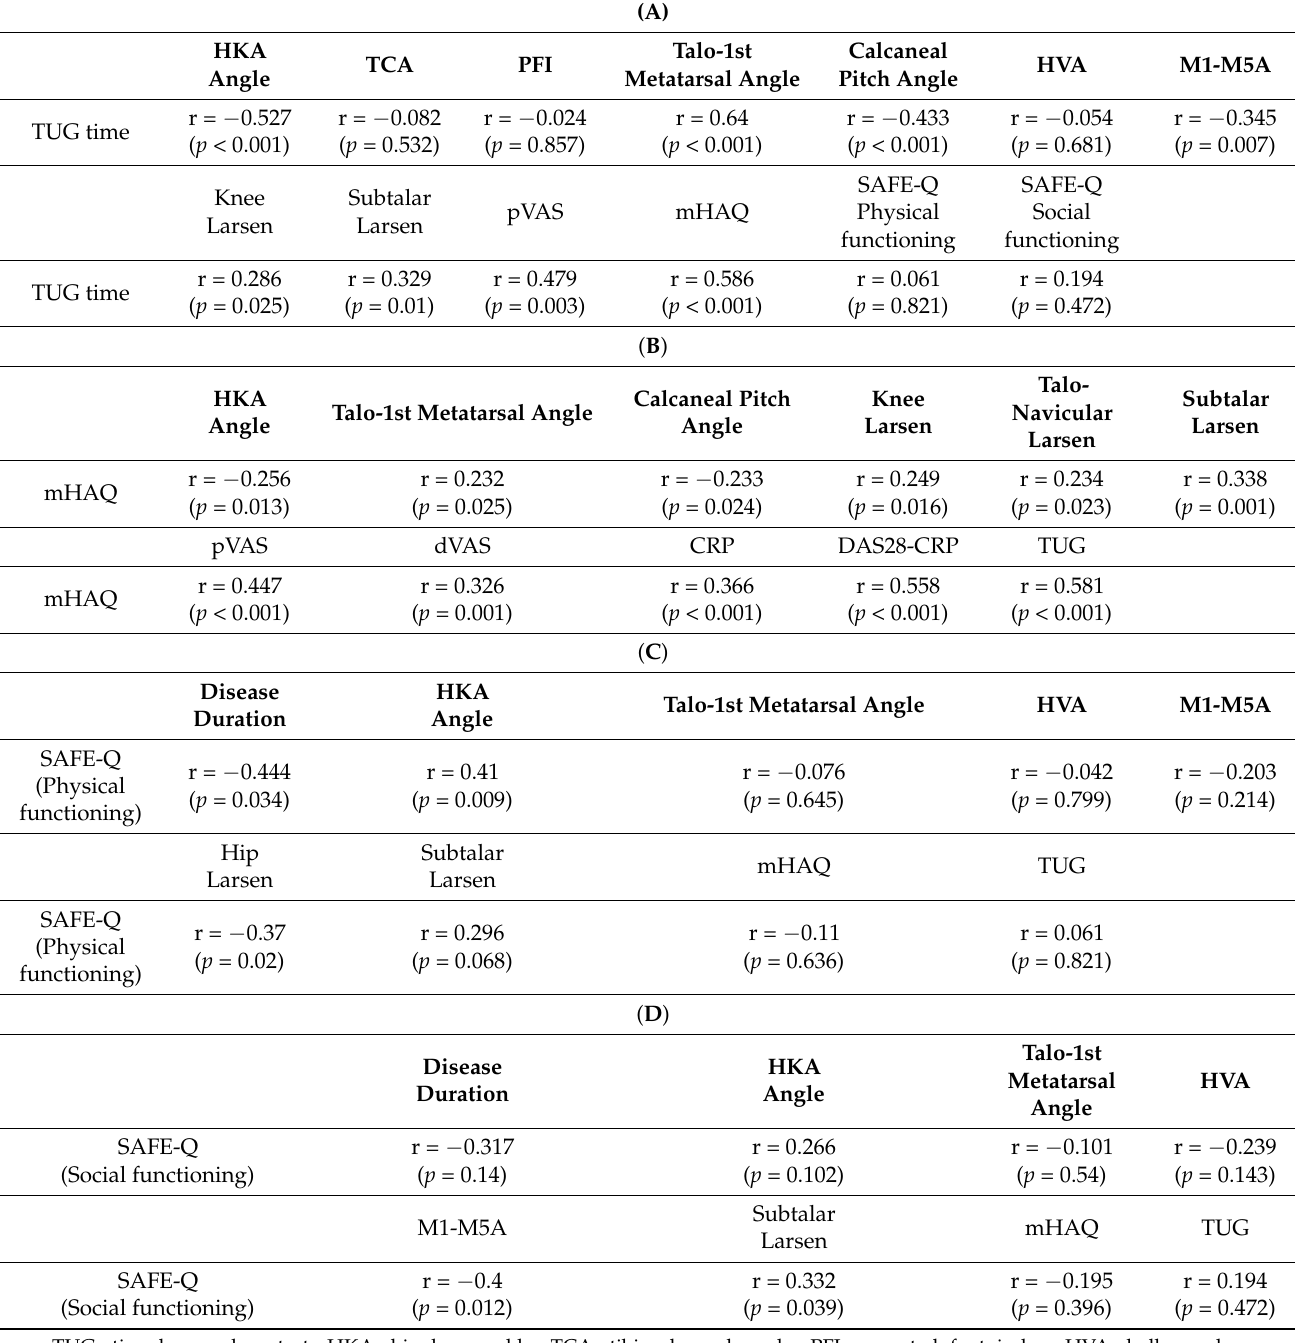
Table 3. Correlation coefficients between physical activity/ADL and other parameters. ( A ) Correlation coefficients between TUG time and other parameters. ( B ) Correlation coefficients between mHAQ and other parameters. ( C ) Correlation coefficients between SAFE-Q (physical functioning) and other parameters. ( D ) Correlation coefficients between SAFE-Q (social functioning) and other